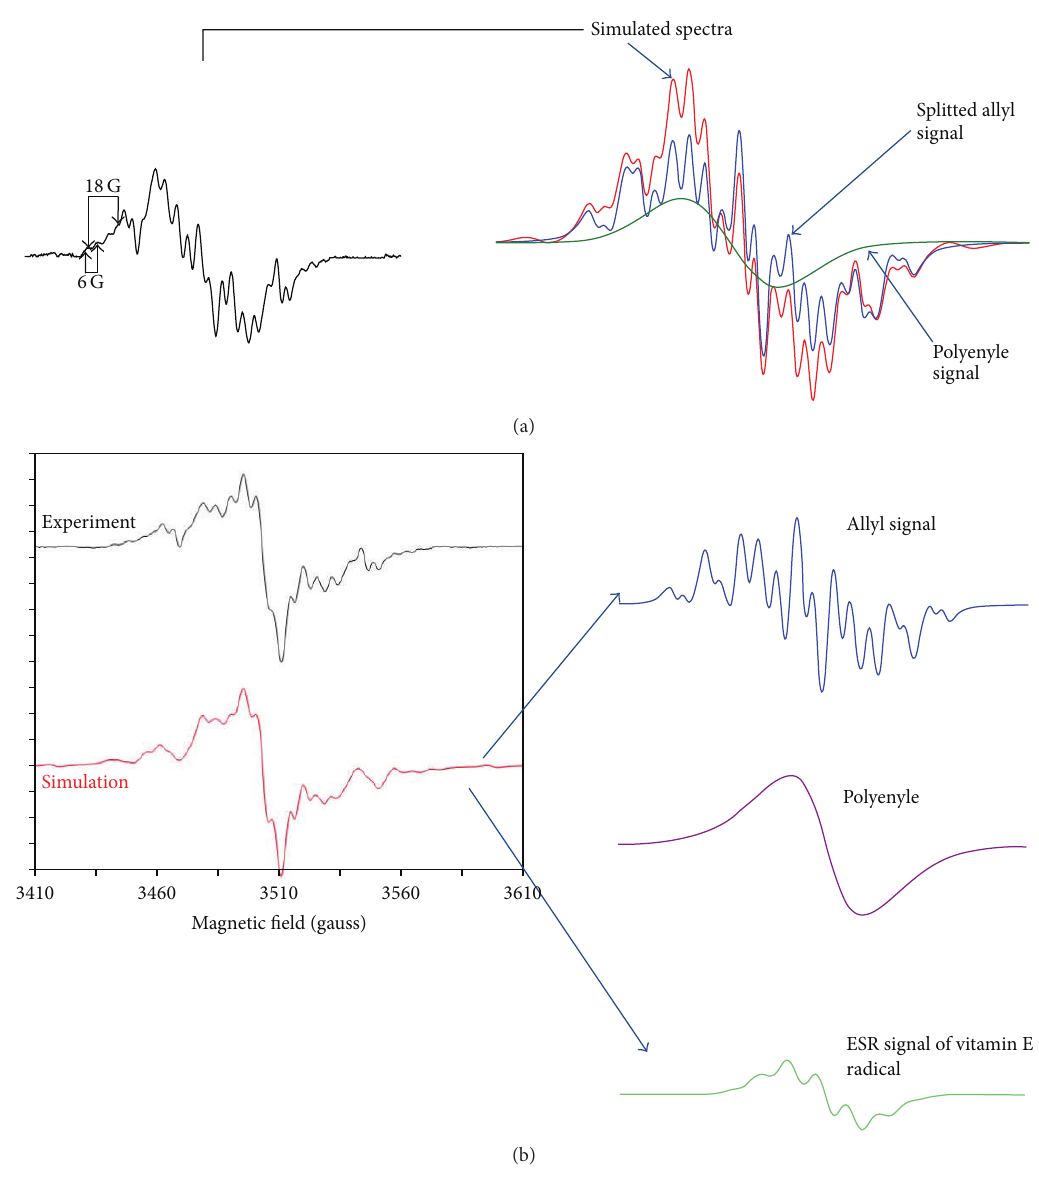
Figure 7: Spectrum deconvolution using WinSim software (a) pristine UHMWPE and (b) vitamin E blended